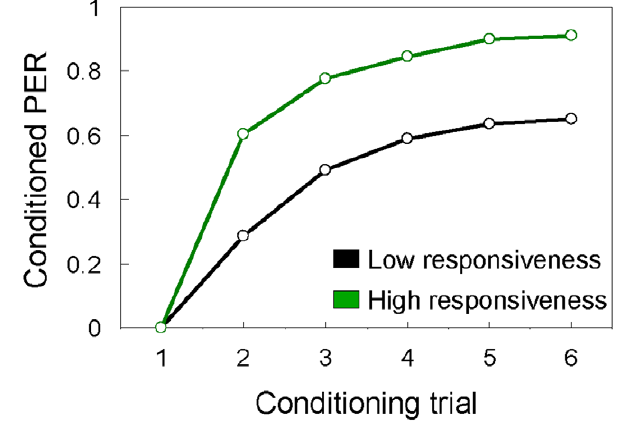
Figure 2. Olfactory learning in worker honeybees with different metabolic stress resilience. Acquisition (learning) curves for the proportion of worker bees that showed conditioned responses to an odour (CS) in each of six conditioning trials. Learning was quantified by the bees’ proboscis extension response (PER), which was monitored during every presentation of the odour. Bees that after the conditioning experiment survived # 50 h (black line, N=135) vs. . 50 h (green line, N=255) in hyperoxia (80% O 2 ) are graphed separately. See text for details on statistics.